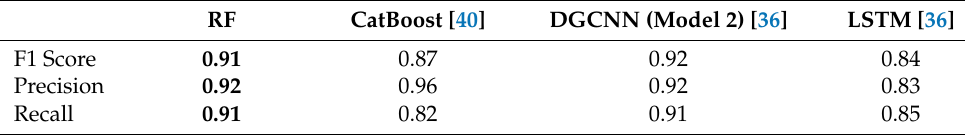
Table 5. Comparative analysis with cutting-edge works (Balanced Data set).